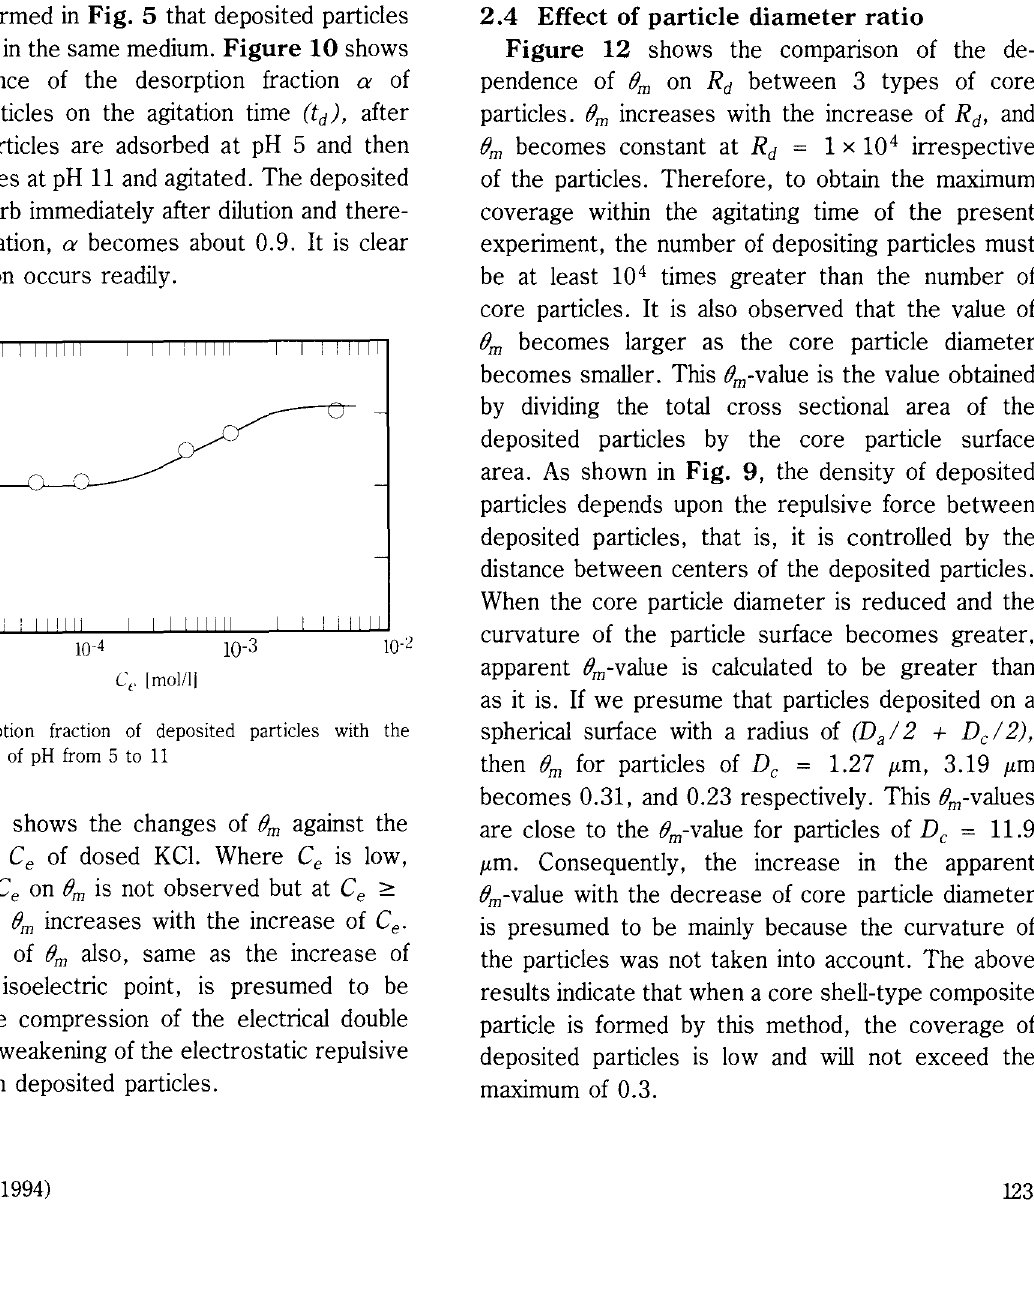
Fig. 11 Dependence of the maximum coverage on KCI con-